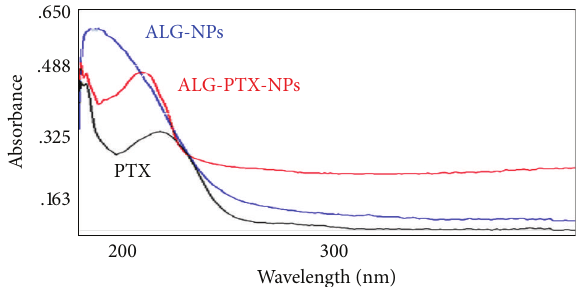
Figure 3: UV/VIS spectra of (a) ALG nanoparticles (blue curve), (b) PTX alone (black curve), and (c) ALG-PTX nanoparticles (red curve).